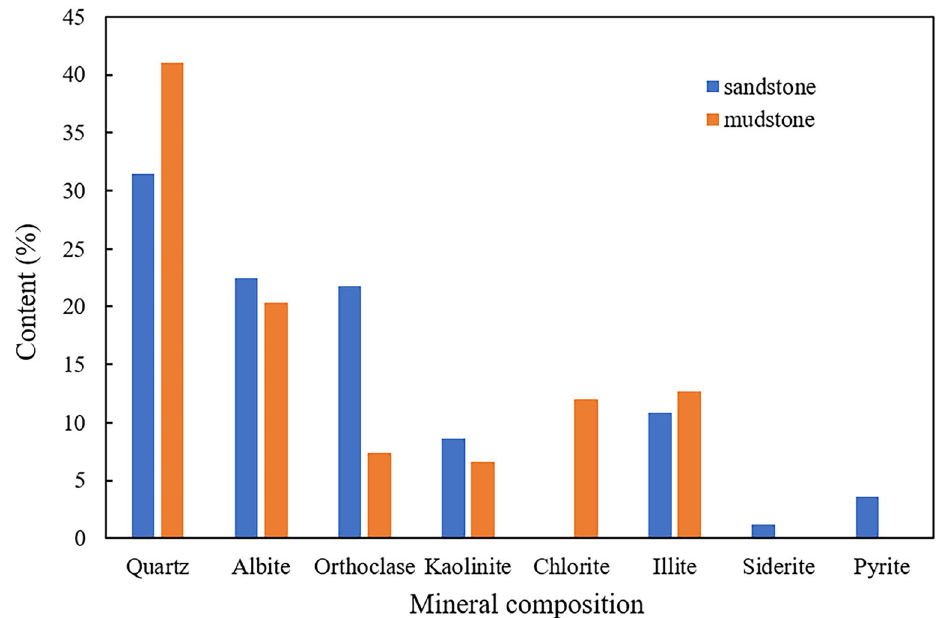
Fig. 7 Mineral composition of rock